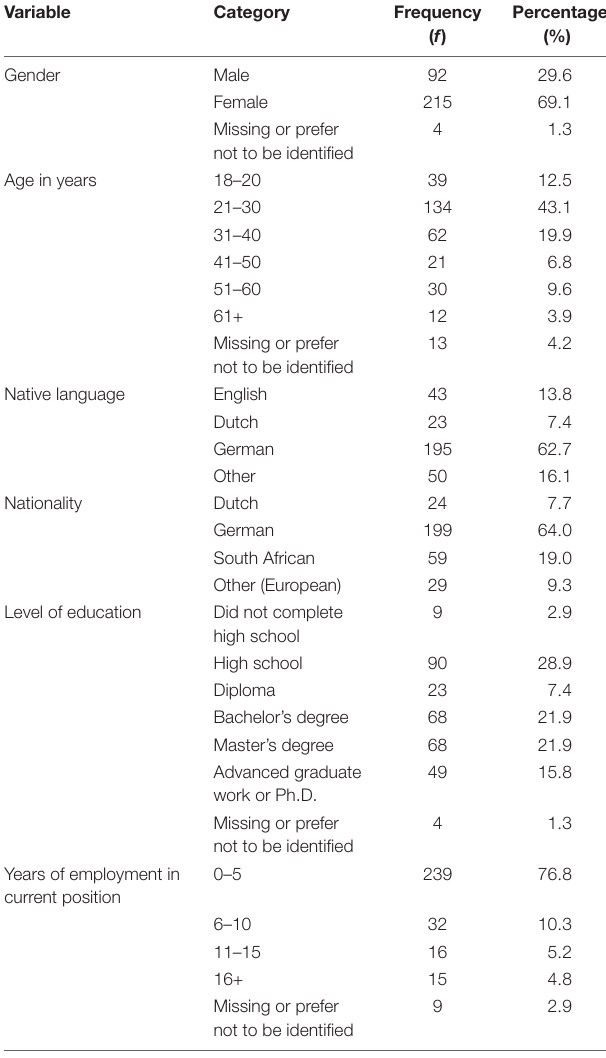
TABLE 1 | Demographic and biographic